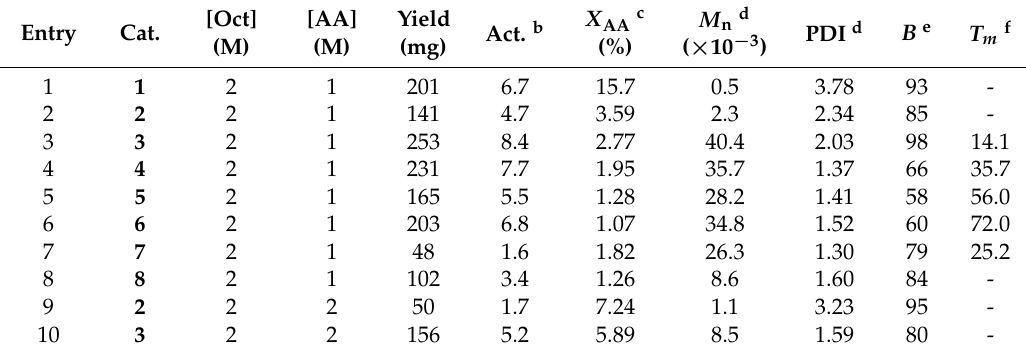
Table 2. 1-Octene (Oct)-acrylic acid (AA) copolymerization a . Entry